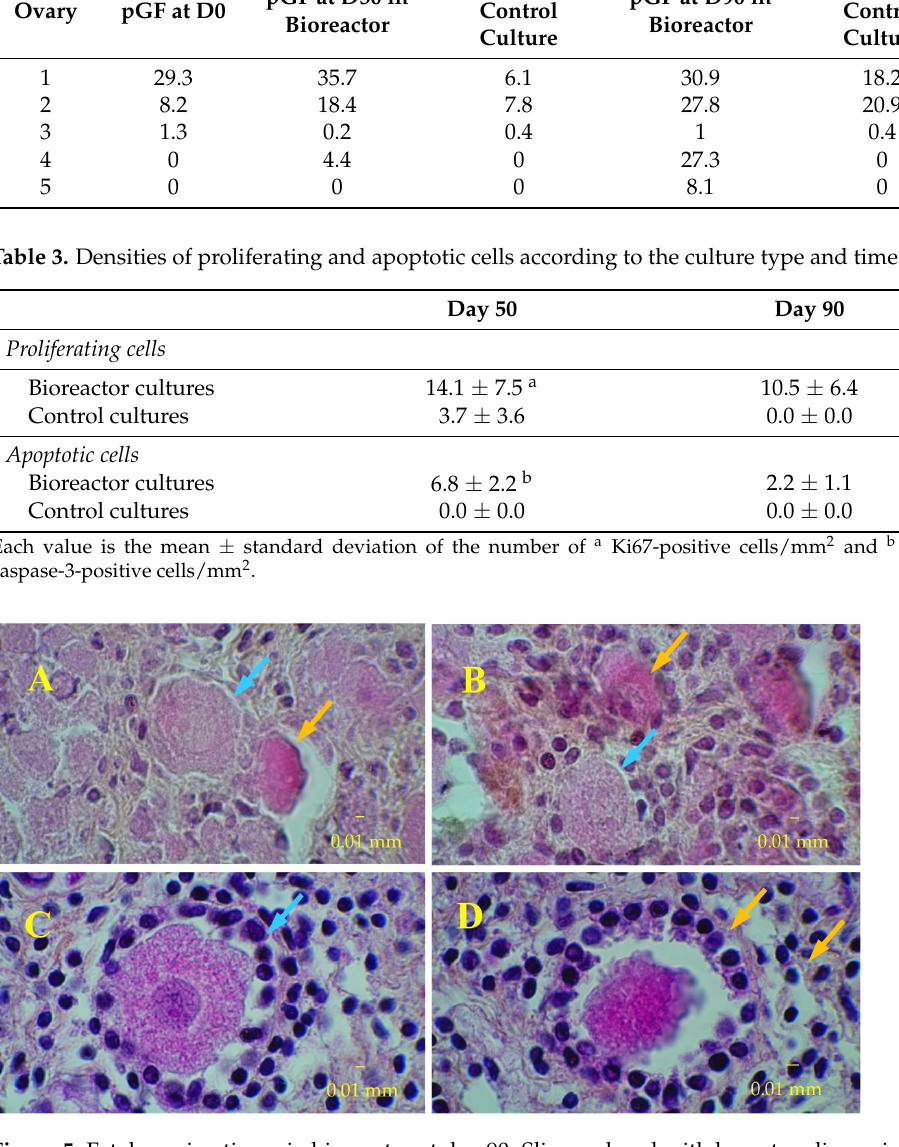
Table 2. Percentages of growing follicles (pGF) relative to all follicles present according to the cul- ture time and type.